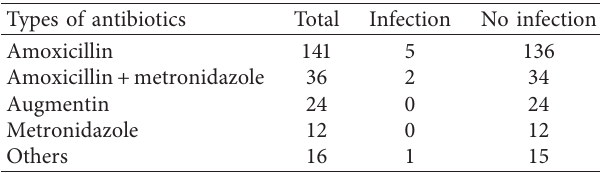
Table 4: Antibiotics prescribed for tooth extraction.